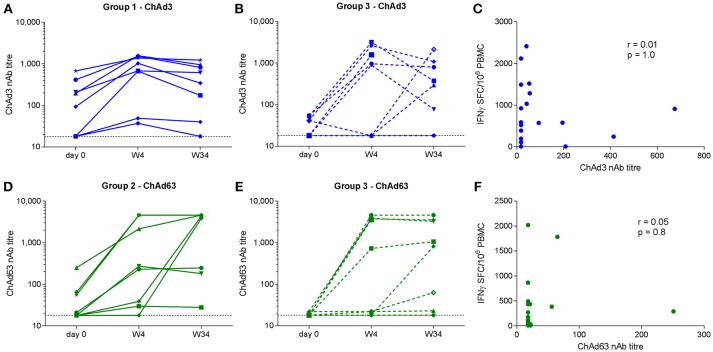
Neutralizing antibody titres to ChAd3 (A,B) and ChAd63 (D,E) measured in serum on day 0, week 4, and week 34 (end of trial) in volunteers receiving single (left) and combined (middle) vaccination regimens. Horizontal dotted line indicates assay cut-off (titer of 18). Correlation analysis (Spearman) for pre-vaccination vector-specific nAb titres and magnitude of the respective total transgene-specific T cell responses at W4 are shown in (C,F).